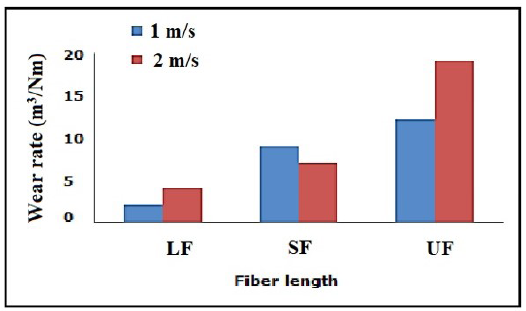
Figure 8. Influence of the load Vs coefficient of friction of the different composite